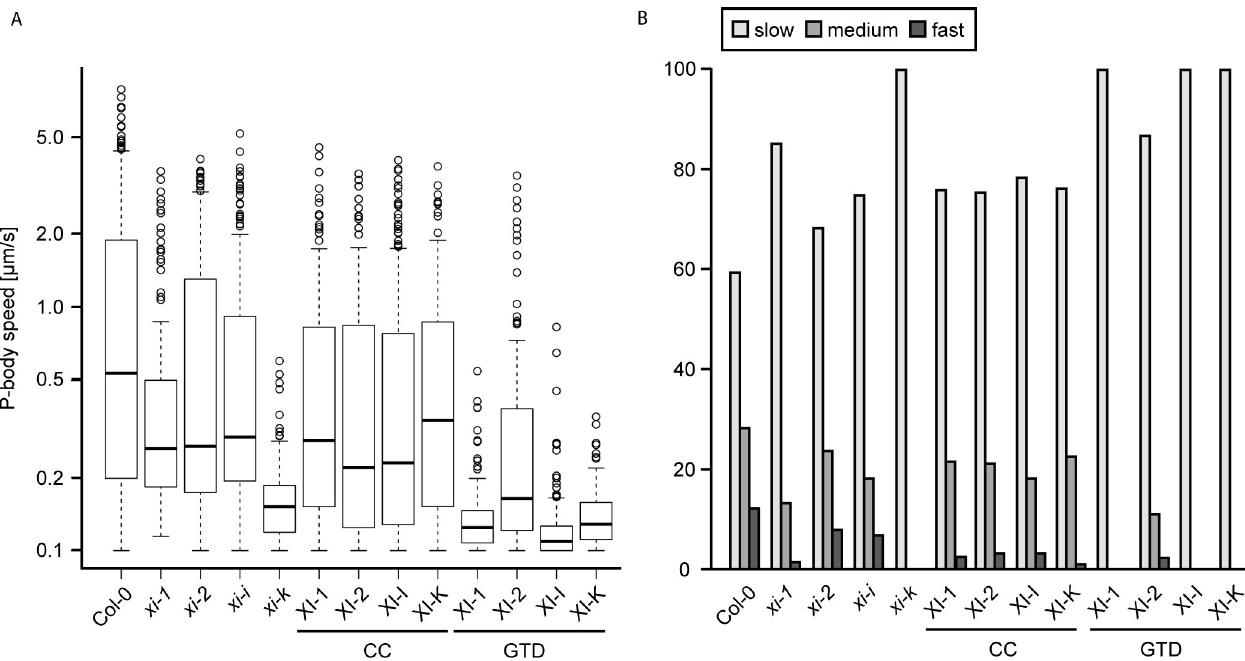
Fig 8. Motility of P-bodies in myosin single mutants and under the dominant negative effect of myosin fragments in Arabidopsis thaliana leaf midvein cells. (A) Speed boxplot and (B) Speed classes of manually tracked DCP1-marked P-bodies in myosin single mutants or in the presence of myosin fragments in Col-0 in percent. Significance was determined by a two-sample Wilcoxon test at p < 0.001, p < 0.01, and p < 0.05 (S2